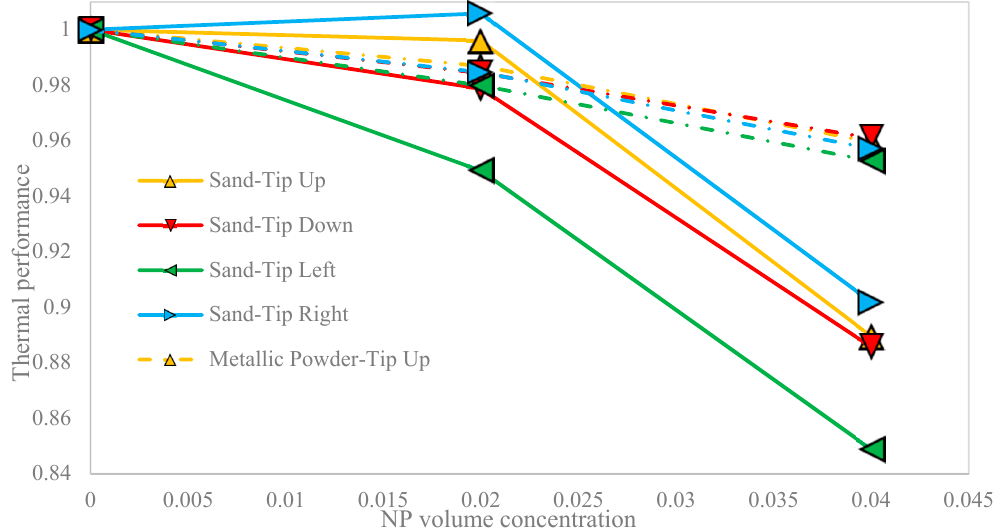
Figure 14. The thermal performance of the different porous cavities against the NP volume concentration in all cases.